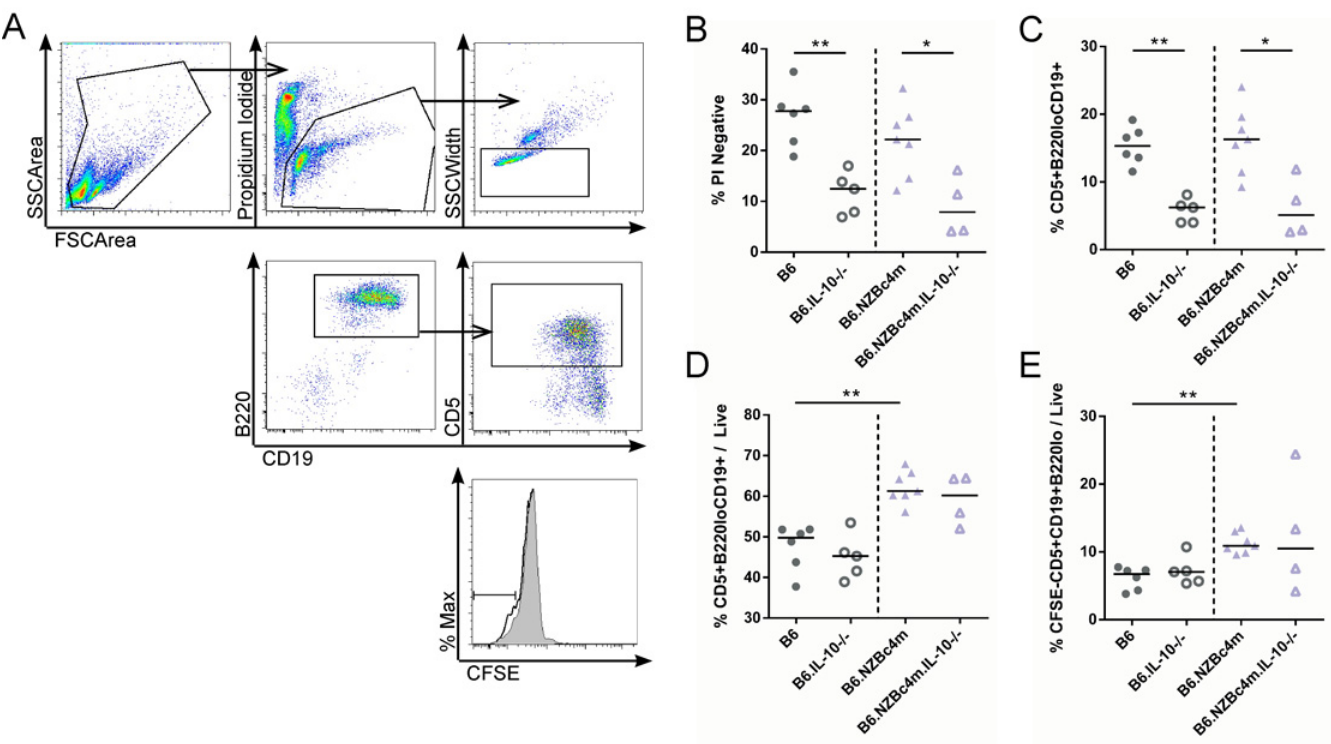
Fig 6. IL-10 is required for cell survival but has no impact on the proliferation of peritoneal B1a cells. Peritoneal B cells were harvested and stained with CFSE as described in the Materials and Methods. Cells were cultured without stimulation for 5 days and homeostatic turnover measured by flow cytometry. (A) Representative gating of live (PI - , Doublet-excluded), B1a (B220 lo CD19 + CD5 + ) and proliferating (CFSE lo ) cells is shown. Frequency of all live cells (B) and proportion of B1a cells within the live population (C) were measured by flow cytometry as a proportion of total events. The frequency of B1a cells (D) and proliferated B1a cells (E) as a proportion of live cells was measured by flow cytometry. Each point represents a single mouse, with the lines for each group representing the median. Statistical analyses were carried out using a Mann-Whitney U test between homozygous and IL-10 knockout animals of the same genetic background. * P < 0.05, ** P < 0.01.